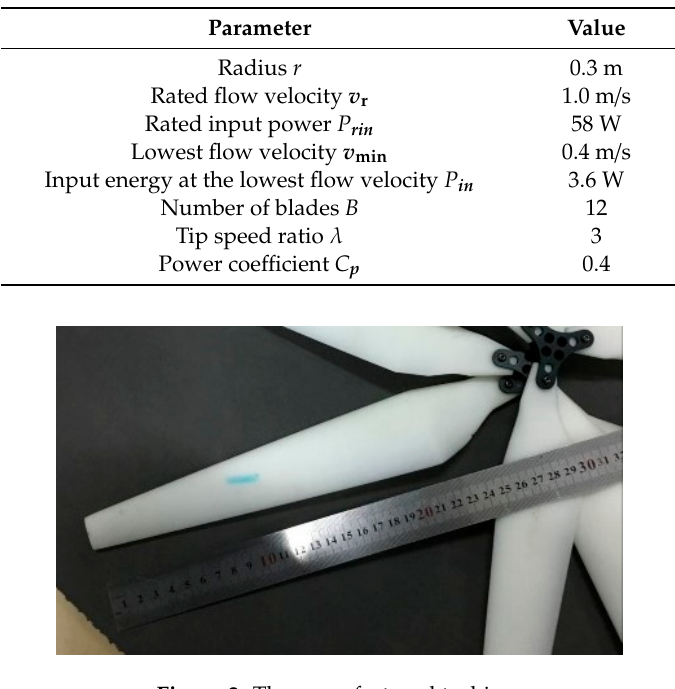
Figure 2. The manufactured turbine.